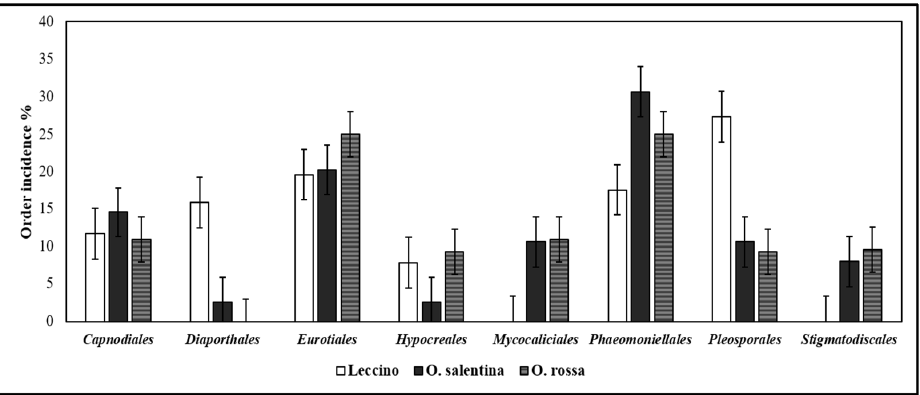
Figure 5. Taxonomic distribution of the endophytic fungi, which were isolated from the twigs of Leccino, O. salentina, and O. rossa cultivars identified by ITS sequencing. The 60 fungal isolates were classified to 14 genera based on their ITS sequences, with representative isolates being deposited under specified accession numbers (Table 2). Cla-